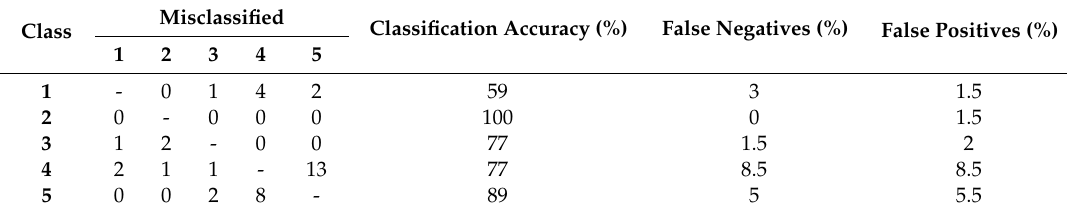
Table 1. Number of misclassified seed in each damage group, classification accuracy, false negative and false positive percentage for each damage class